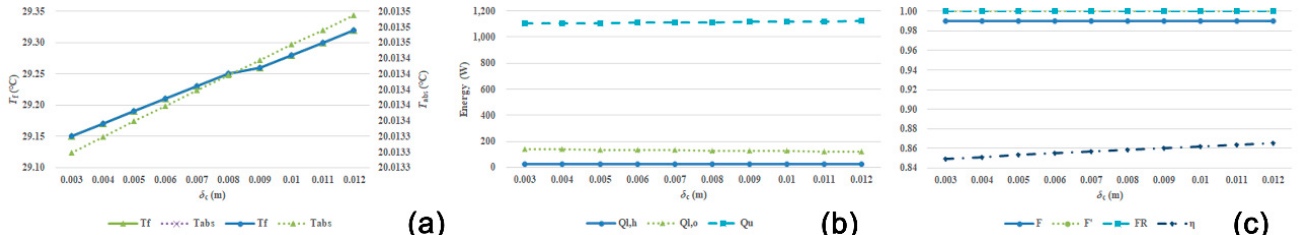
Figure 18. Influence of transparent cover refractive index ( r ) . ( a ) Dependence between T f , T abs , and r . ( b ) Dependence be ‐ tween energy, and r . ( c ) Dependence between efficiency parameters, and r . 5.3. Optimization Results Effective ways to improve the efficiency of the VTBC solar collector were to increase τ , N, and δ c . Among these, the most useful and low ‐ cost method was to use a transparent cover with a high τ (Table 3). Therefore, this study increased τ to 0.96 individually by replacing the normal glass cover with an ultraclear glass cover. According to the calcula ‐ tion results, the instantaneous efficiency equation of the optimization model was η = 0.92 − 2.20 T m *. Table 3. Sensitivity analyses of τ , N, and δ c . Key Parameter